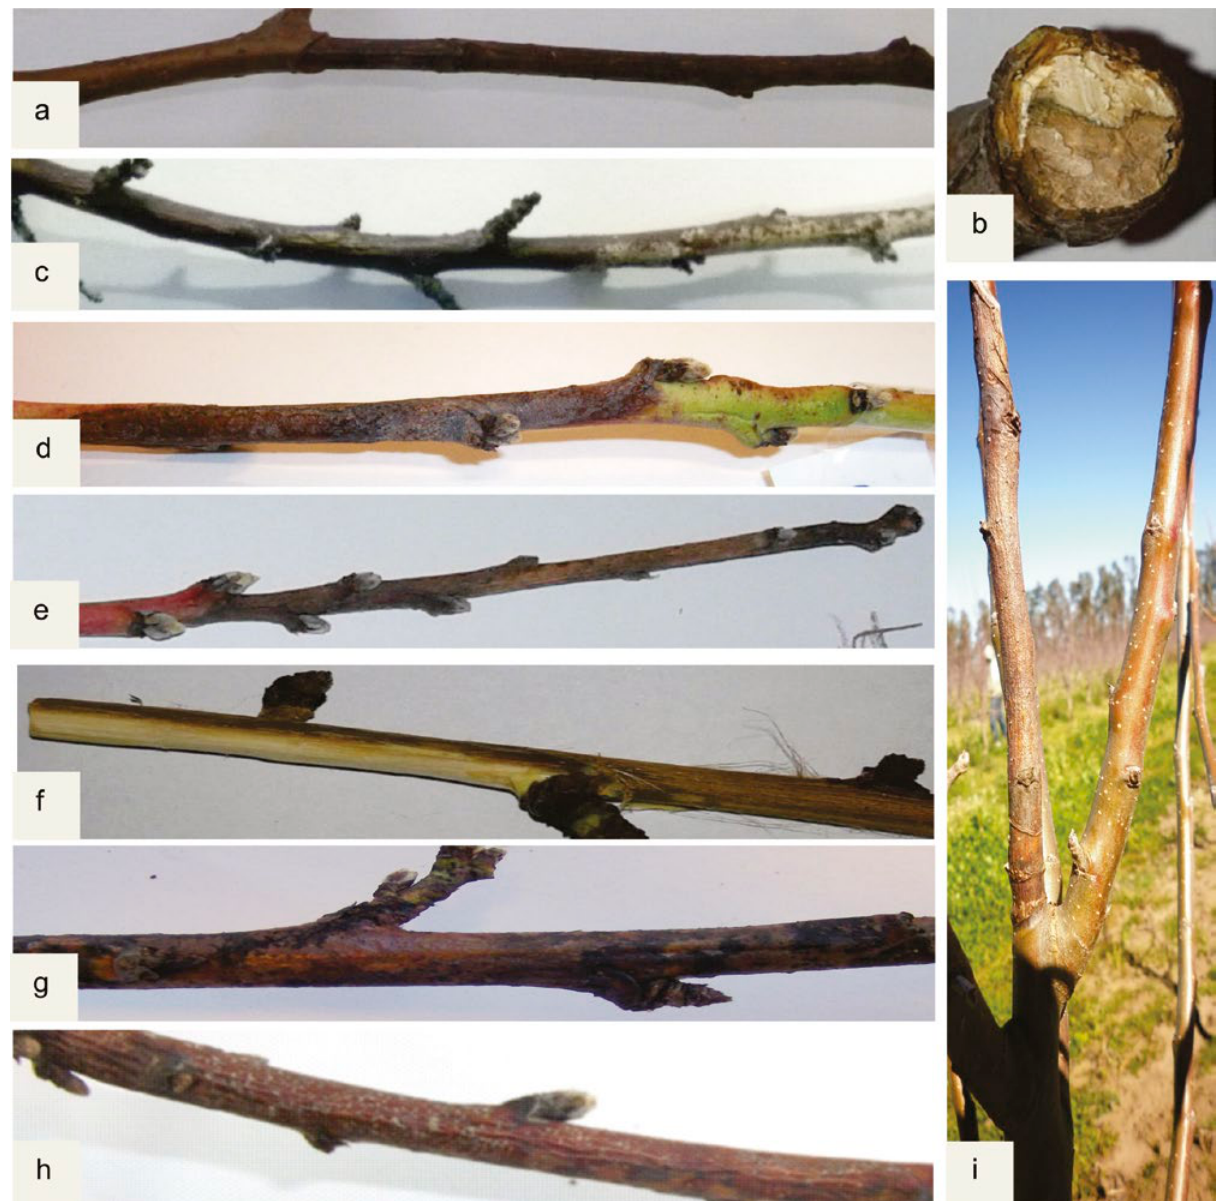
Figure 1. Disease symptoms observed on twigs and branches of pear (a-b), peach (c-h) and apple (i) trees in Uruguayan orchards. (a) apical dead shoot ( Diaporthe phaseolorum , D. terebinthifolii ); (b) Wedge-shaped necrosis ( D. infecunda, D. eres ); (c) whitish dead twig; (d) shoot blight with gummosis; (e) apical dead shoot ( D. amygdali ); (f) Internal necrosis ( D. oxe ); (g) black and reddish necrosis ( Diaporthe sp. 1); (h) reddish necrosis ( Diaporthe sp. 1); (i) reddish sunken canker ( D. eres , D. foeniculina